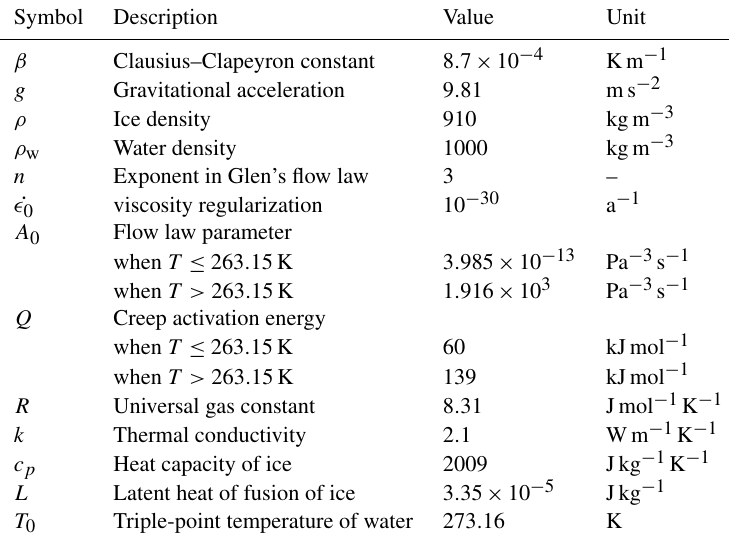
Table 1. Parameters used in this